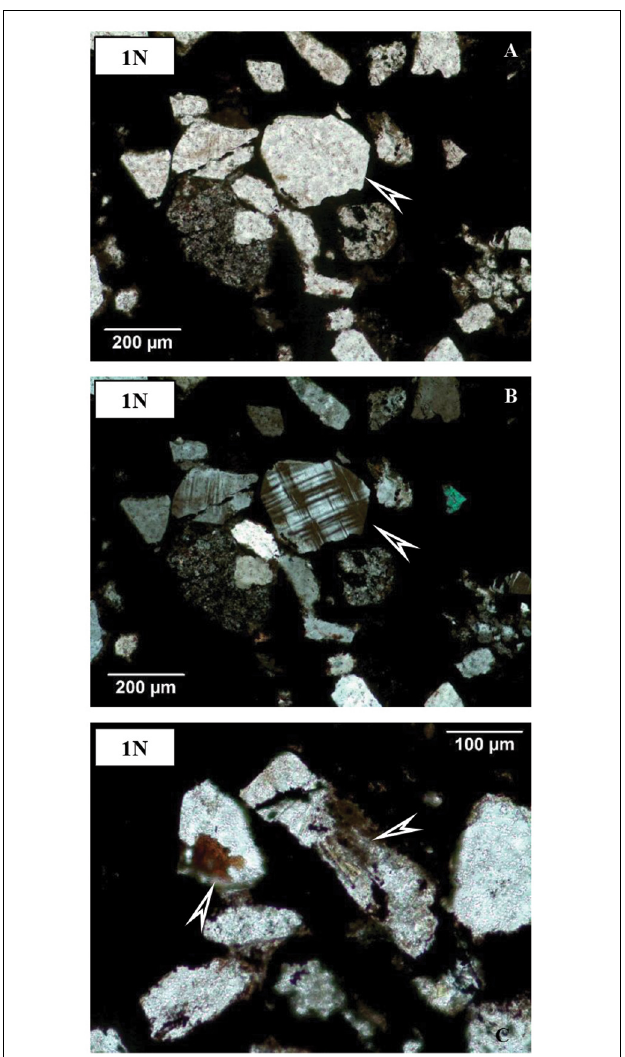
FIGURE 6 | Microtextural features of sample COR-31 by OM. (A) Debris-like grains (mainly quartz, altered feldspar, and fragments of jasper) in opaque matrix (arrow, 1N, and transmitted light). (B) Crossed N of (A) . (C) Brown mineralized microbial biosignatures along and inside debris-like grains (arrows, transmitted light, and